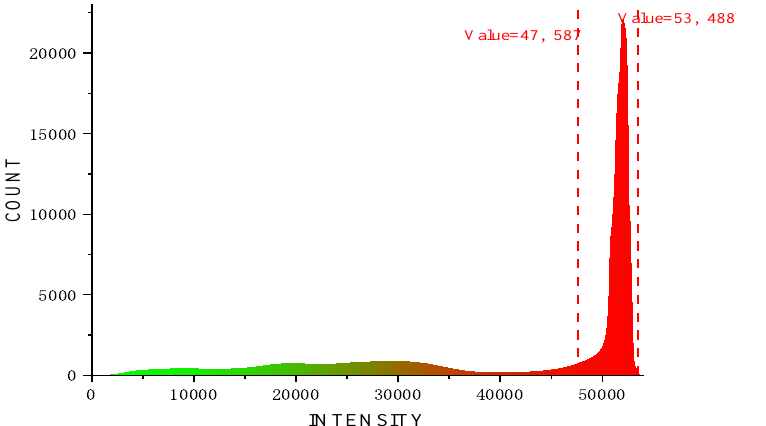
Figure 15. Selecting a range of intensity values of the laser point clouds of Figure 14 for segmentation.